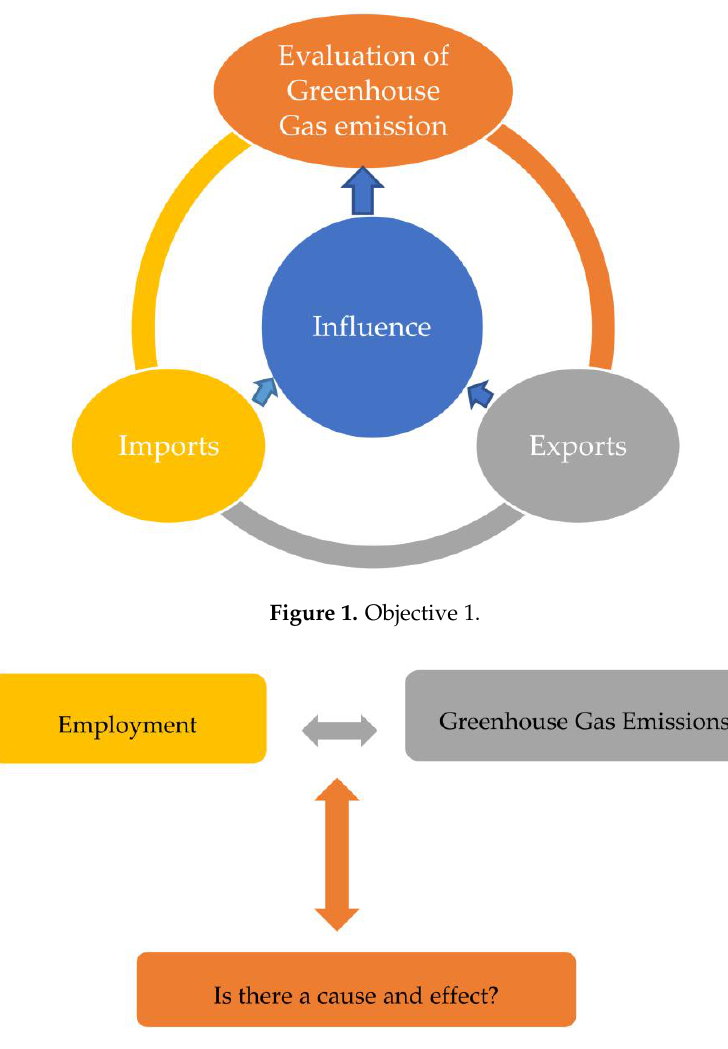
Figure 2. Objective 2. Figure 2. Objective